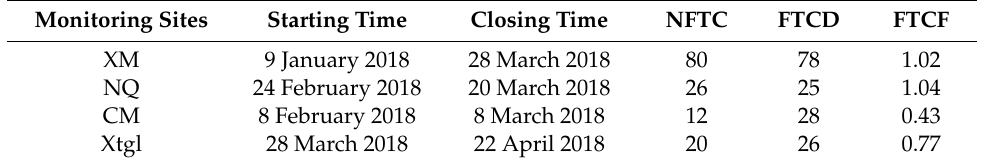
Table 2. Freezing-thawing cycle characteristics of topsoil at four monitoring sites from January